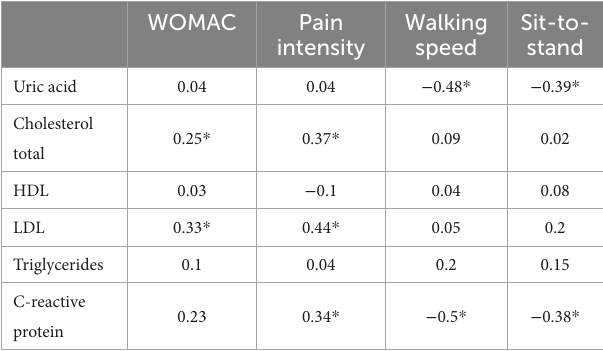
FIGURE 2 Results of inflammatory biomarkers. Results are expressed in ng/mL.